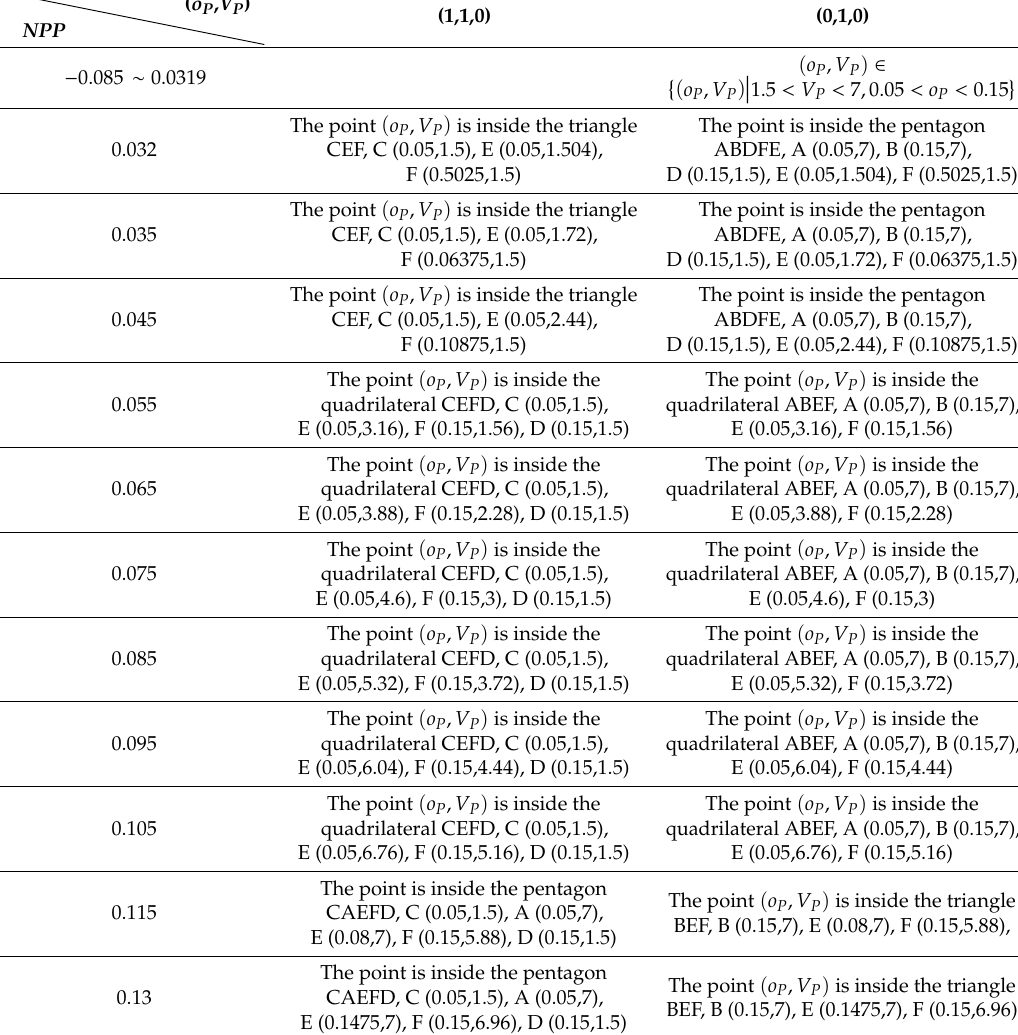
Table A2. Influence of NPP on energy storage selection in power plants.